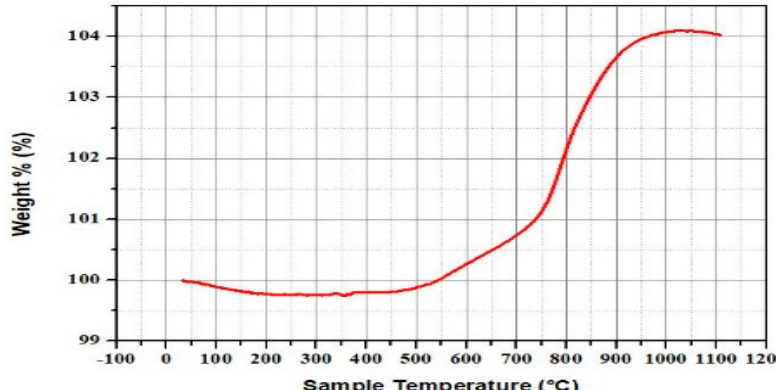
Figure 6. The thermogravimetric analysis (TGA) analysis of GaN waste with the heating rate 10 °C/min.